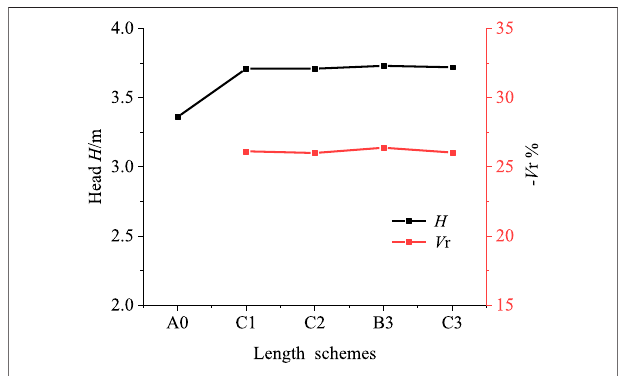
FIGURE 9 | Head and percentage reduction of vacuole volume, NPSH a = 0.054 m.